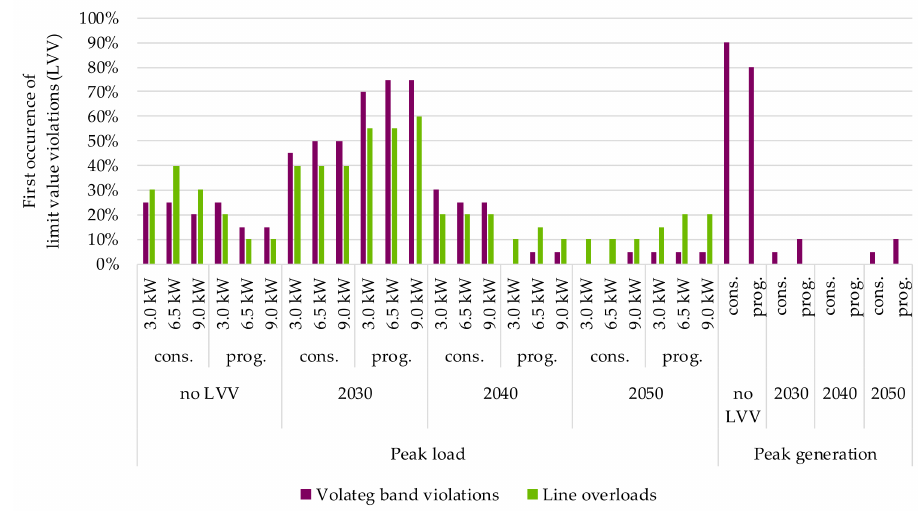
Figure 30. First occurrence of limit value violations for low-voltage lines for the operating points “peak generation“ and “peak load” consolidated for 20 low-voltage grids based on [41].